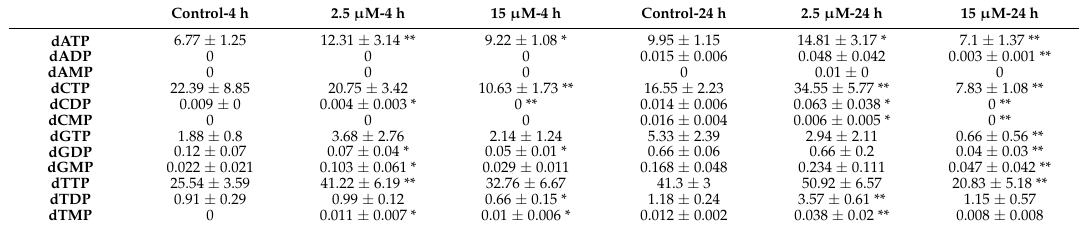
Table 2. Levels of dRNs in HL-60 cells before and after incubation with Ara-C (pmol/10 6